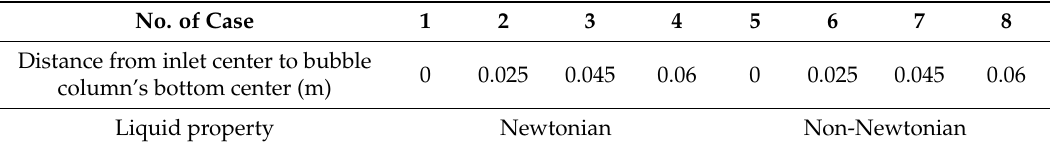
Table 1. Parameters of different calculation cases.